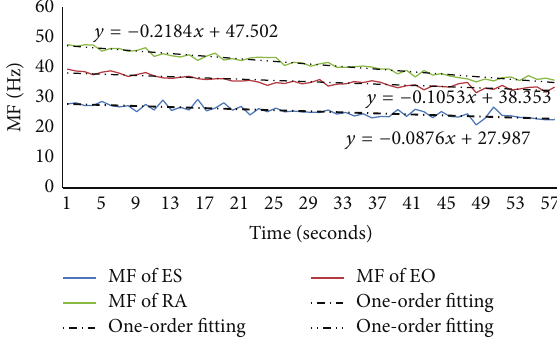
Figure 6: The MF and its one-order fitting for ES, EO, and RA in the prone bridge exercise.